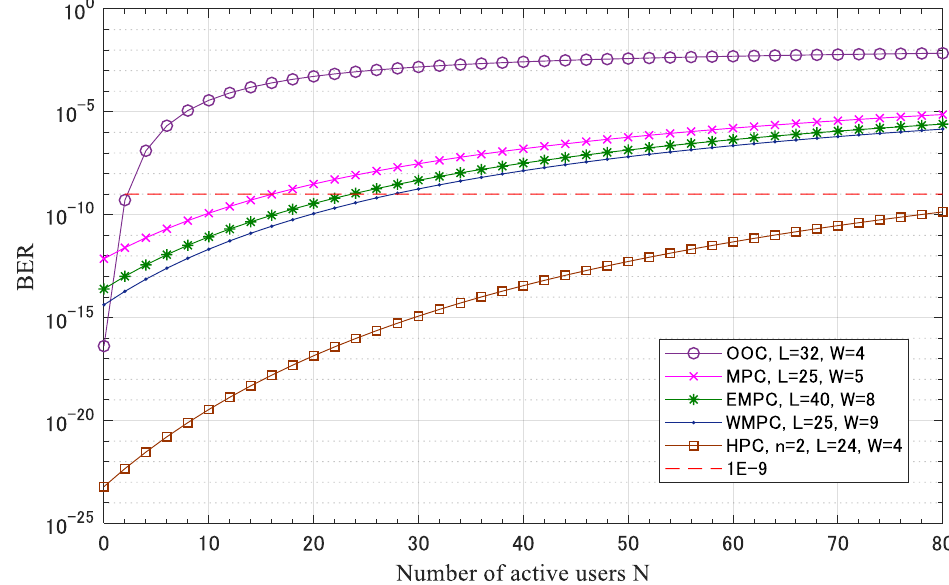
Figure 21. BER of OCDMA systems versus the number of active users N ( n = 2, L = 24 and W = 4).